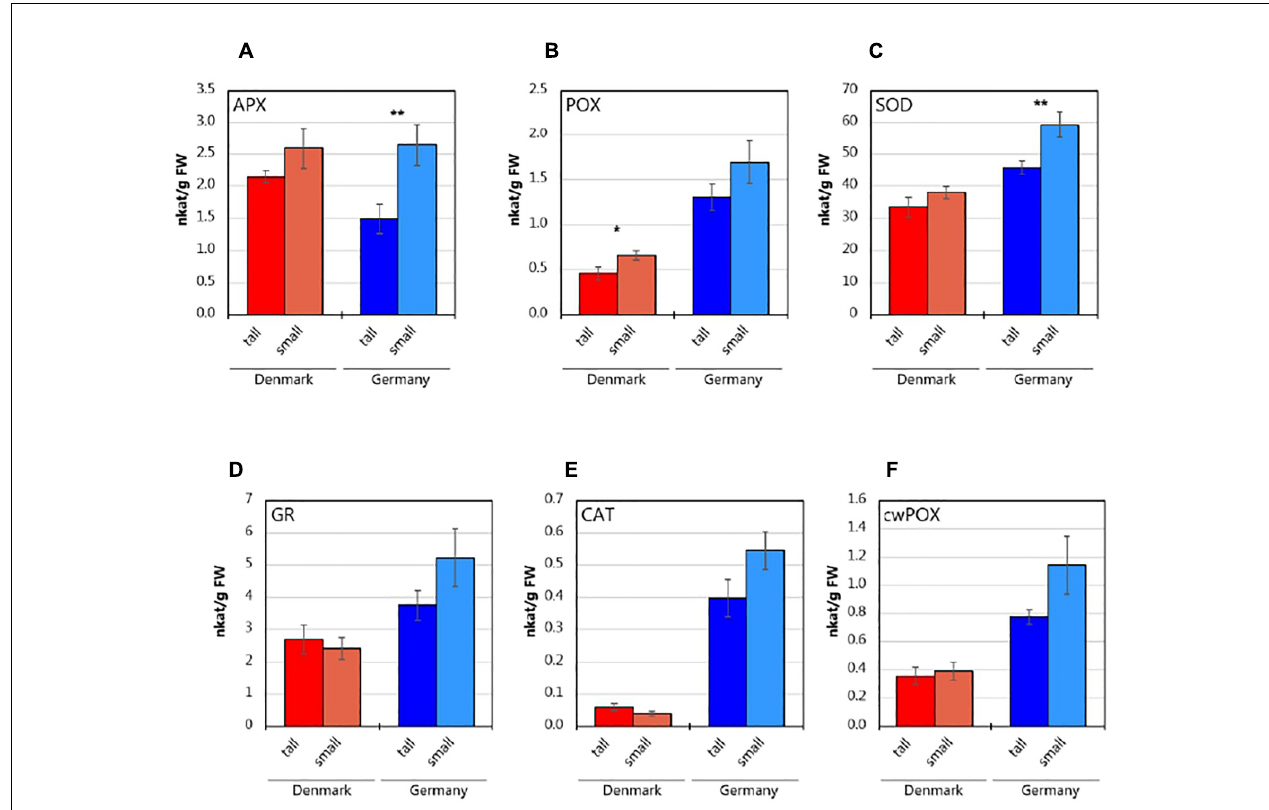
FIGURE 1 | Antioxidative enzyme activities in the roots of tall and small three-year-old A. nordmanniana . (A) Ascorbate peroxidase (APX). (B) Peroxidase (POX). (C) Superoxide dismutase (SOD). (D) Glutathione reductase (GR). (E) Catalase (CAT). (F) Cell-wall peroxidase (cwPOX). Values represent mean ± SEM derived from five biological replicates of three technical replicates each. ∗ , ∗∗ indicate statistically significant differences at the P < 0.05 and P < 0.01 level, respectively, between small and tall plants based on two-sided, unpaired Students t